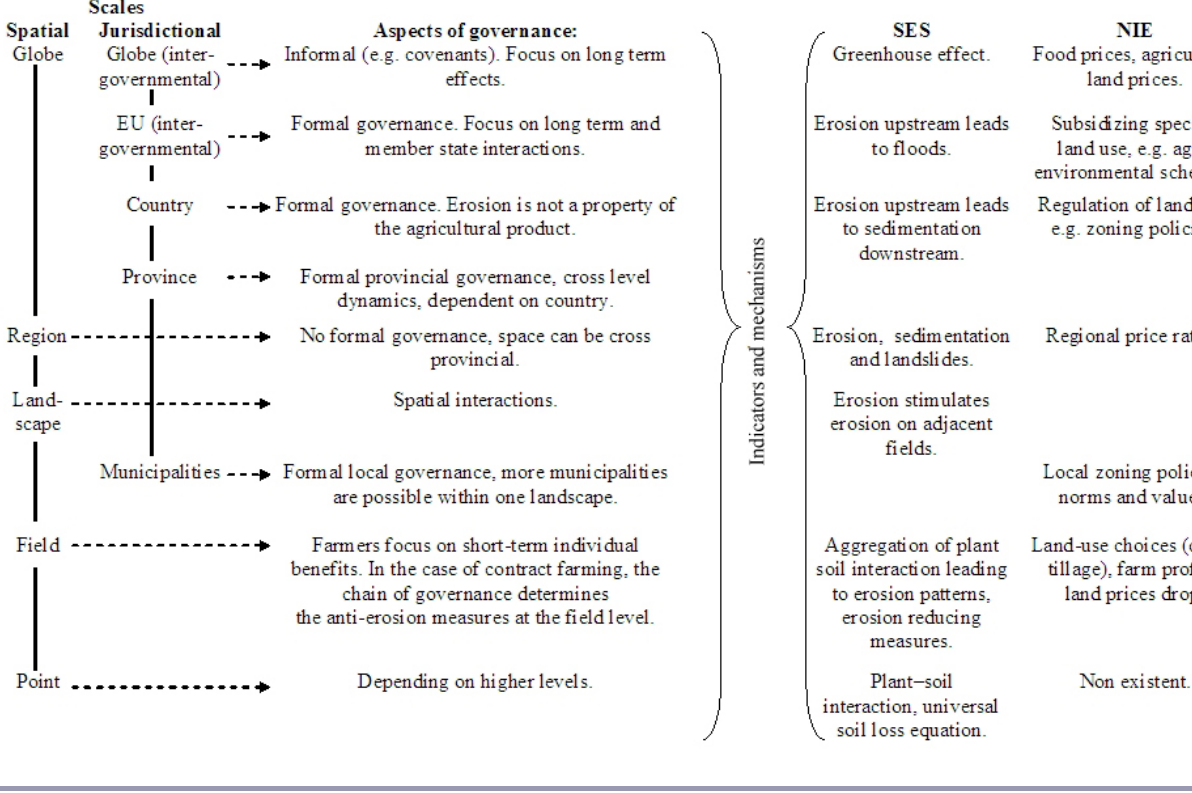
Fig. 2. Scaling and governance issues in the European Union soil